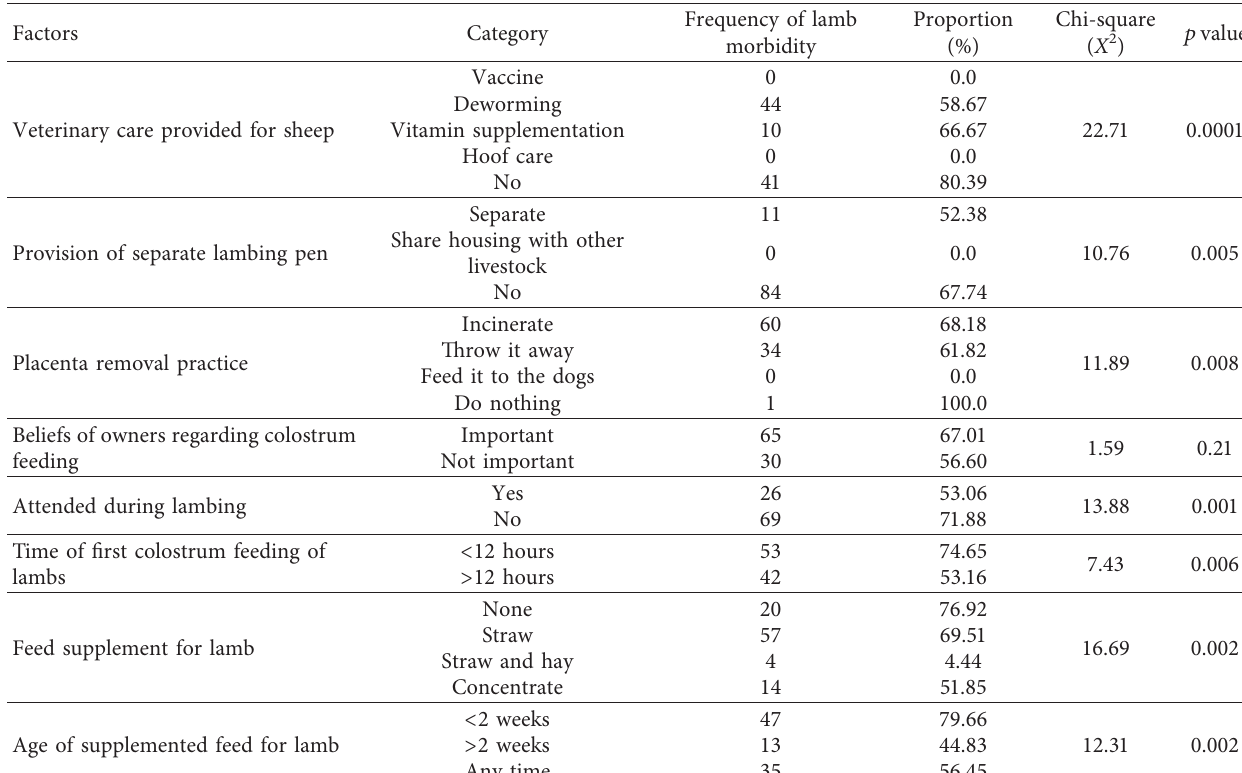
Table 7: Morbidity of lambs on different managemental factors in Jamma district.